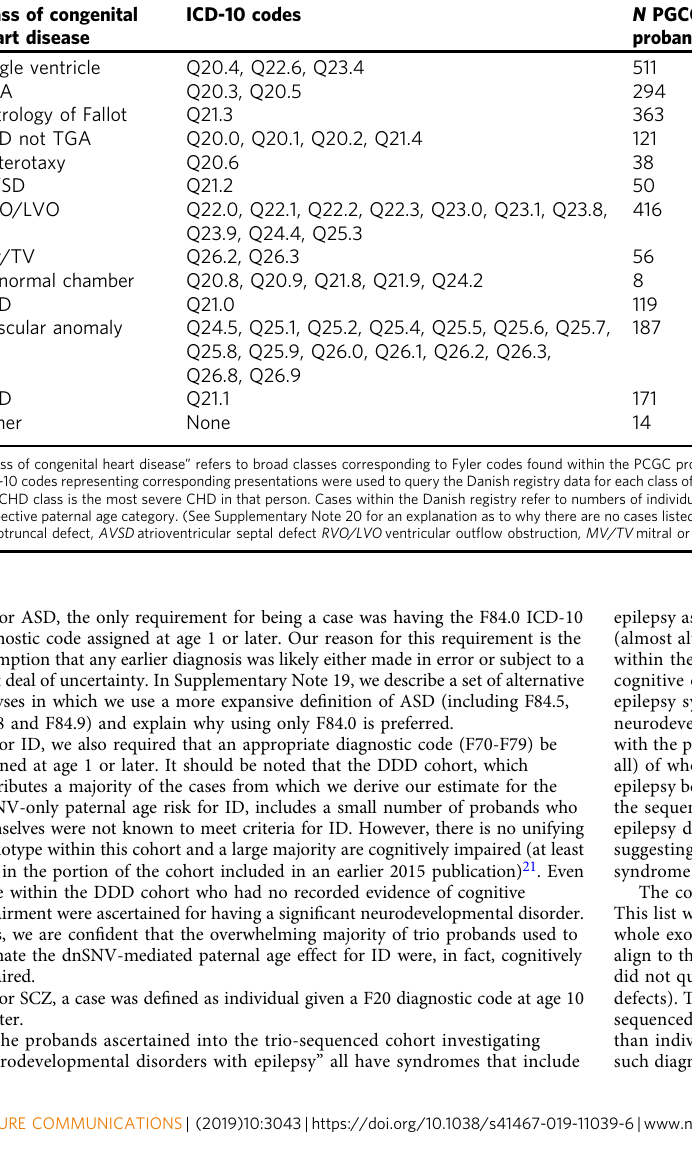
Table 3 Aligning congenital heart disease phenotypes Class of congenital heart